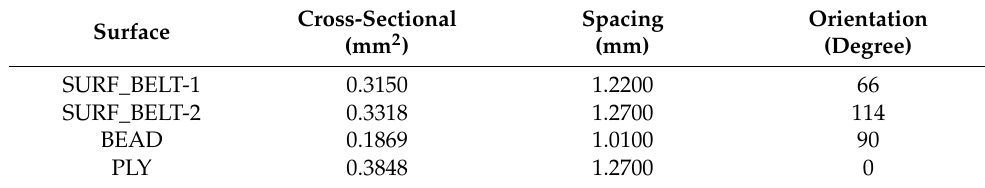
Table 2. The geometric parameter values of reinforcement